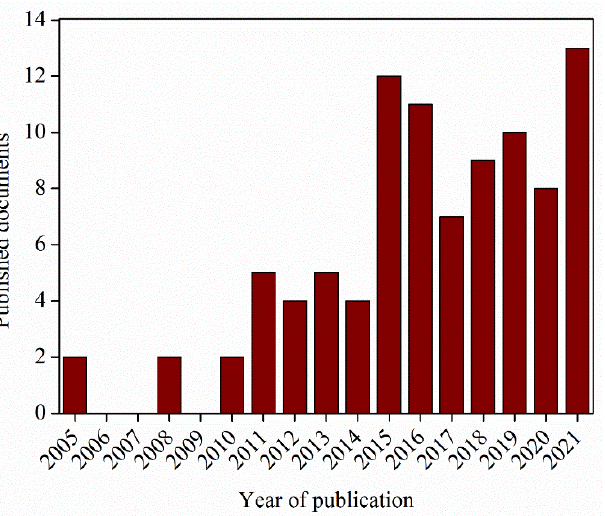
Figure 6. Diagram of the number of documents regarding shape-memory fibers per year (Scopus Source).